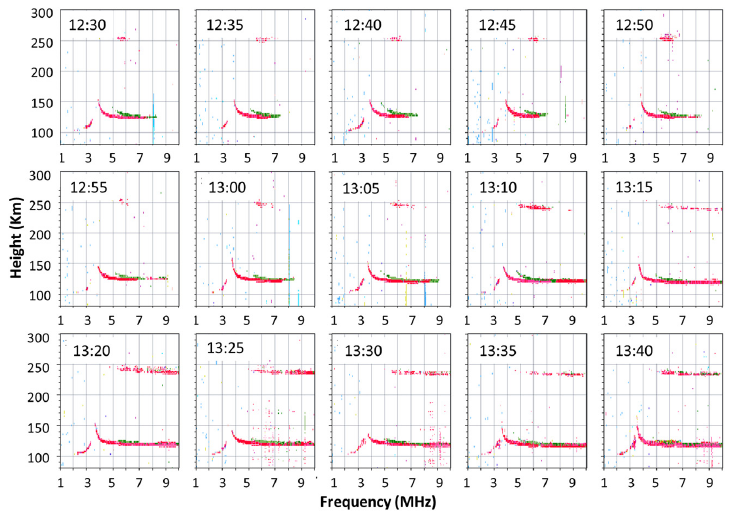
Figure 4. Series of consecutive ionograms with strong (blanketing) Es over Nicosia station.